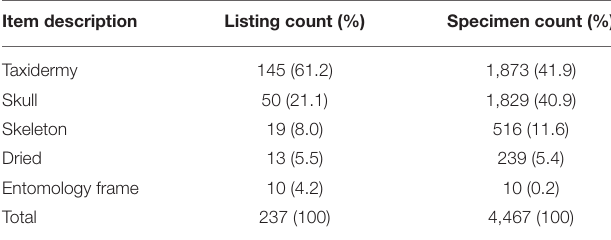
TABLE 1 | Diversity of item’s description across bat listings retrieved from eBay Australia, Canada, Italy, Switzerland, UK, USA between 11th and 25th of